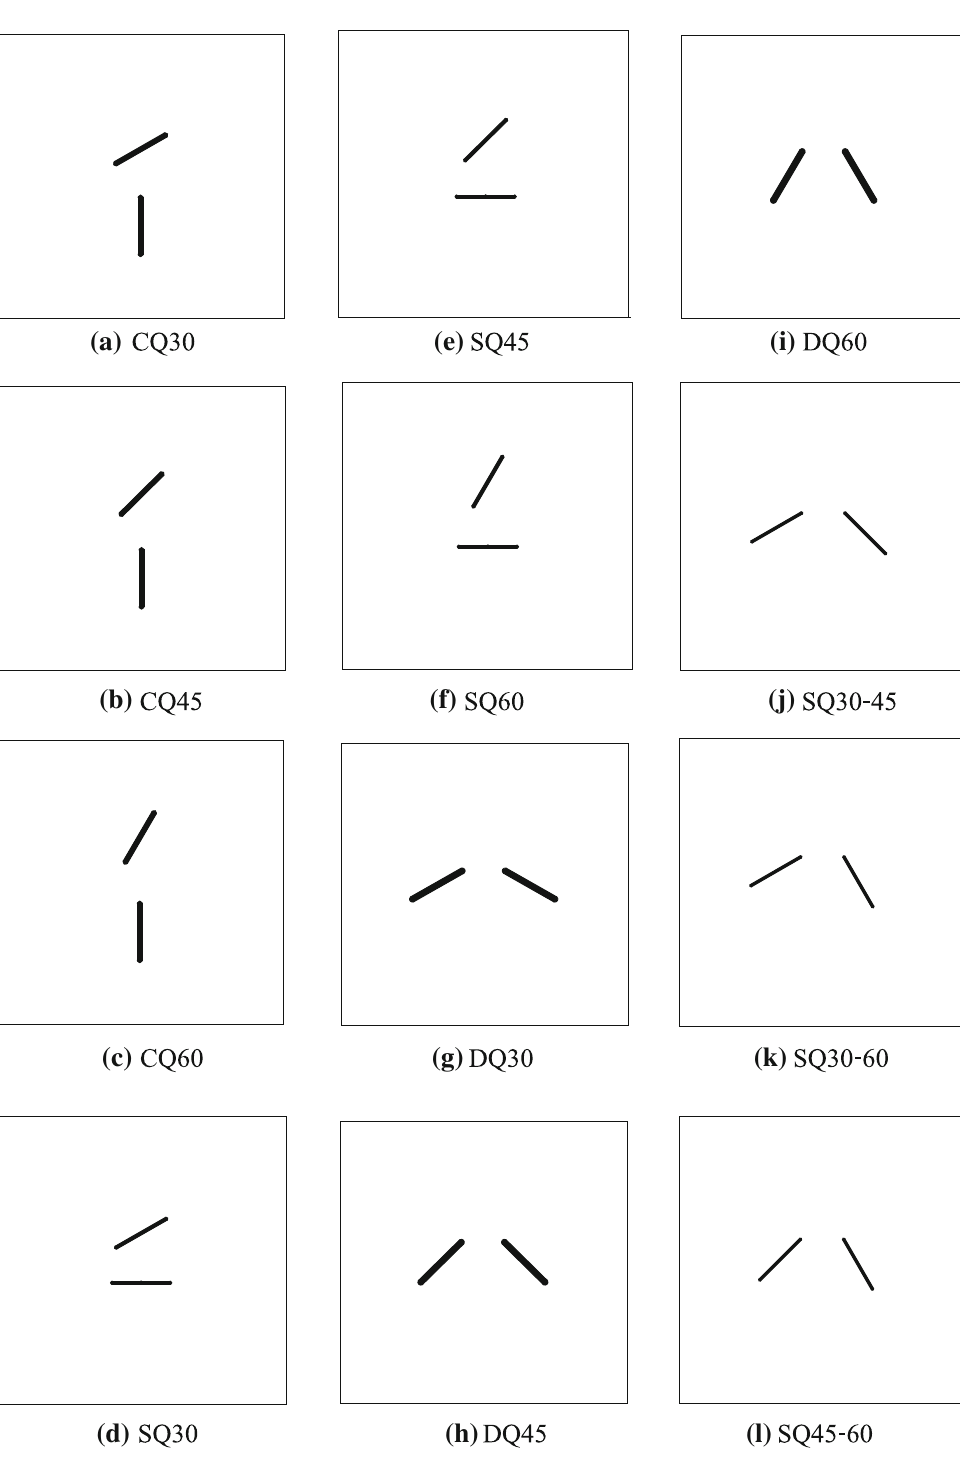
Fig. 2 Diagrams of the fractured